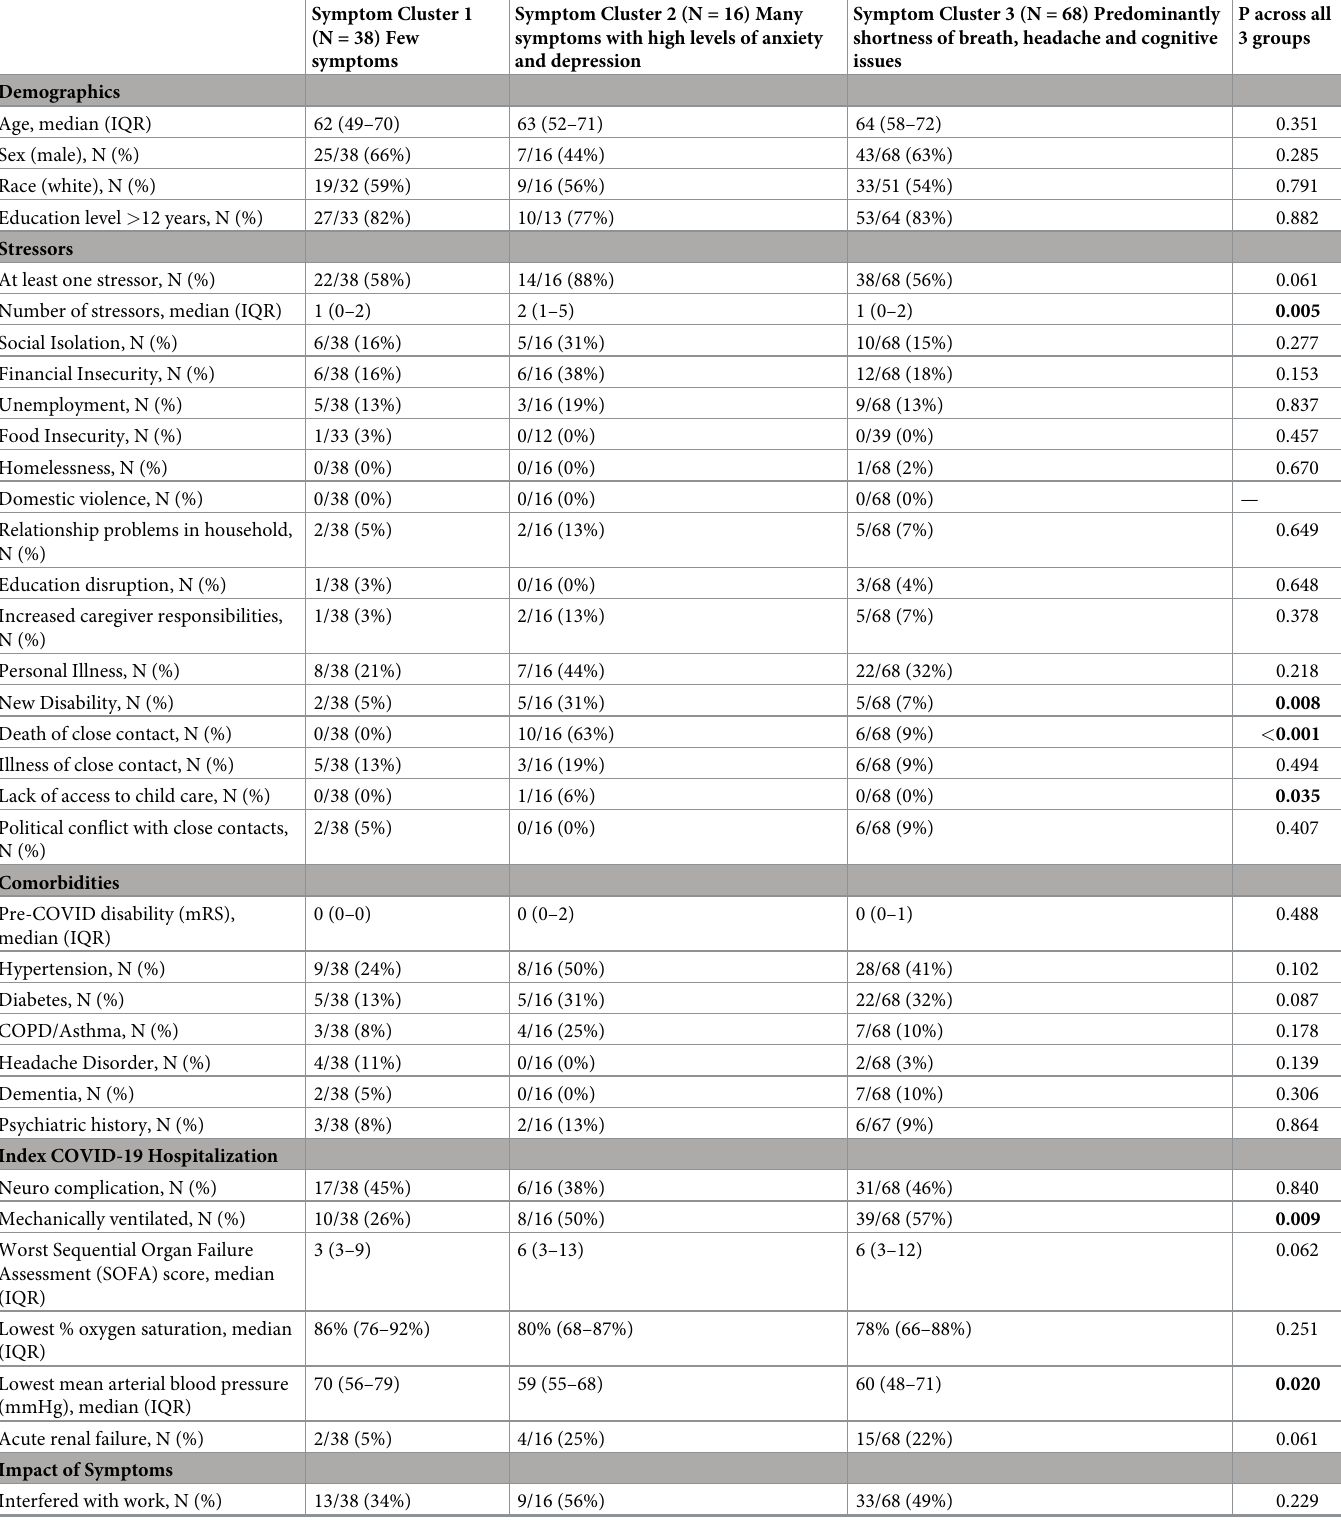
Table 1. Demographics, stressors, co-morbidities, and 12-month metrics among symptoms clusters (N = 122 patients with